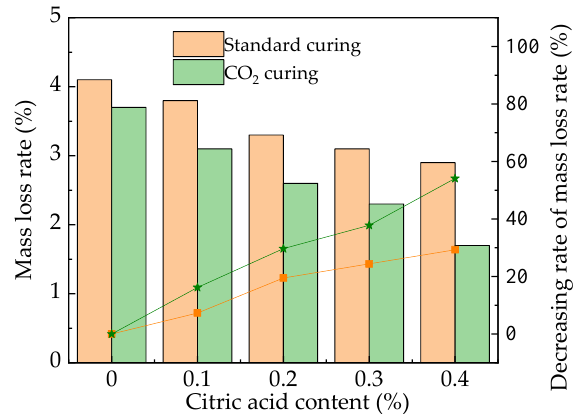
Figure 10. The mass loss rate of the MOS paste after F-T cycles.